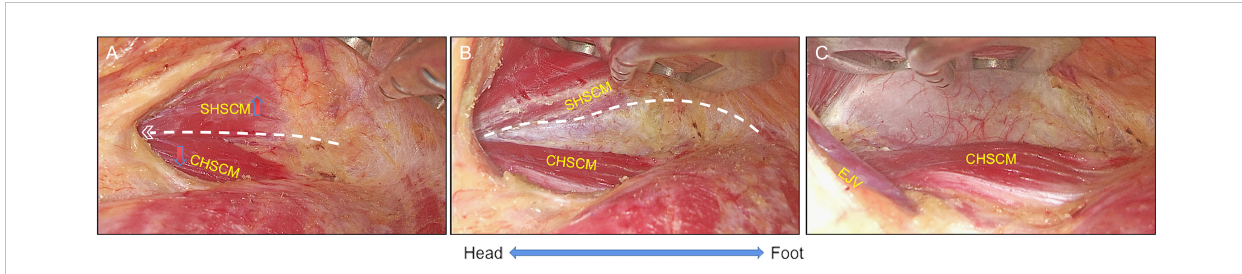
FIGURE 1 The settlement of clavicular head of SCM. (A) The clavicular and sternal head of sternocleidomastoid muscle (CHSCM and SHSCM) were exposed. (B) The space between CHSCM and SHSCM was created, and then the retractor was placed under the SHSCM (white line); (C) The working space was maintained by the retractor, and then deep cervical fascia was revealed and the settlement of CHSCM was done. CHSCM, clavicular head of the sternocleidomastoid muscle; SHSCM, sternal head of the sternocleidomastoid muscle; EJV, external jugular vein. White lines with angle